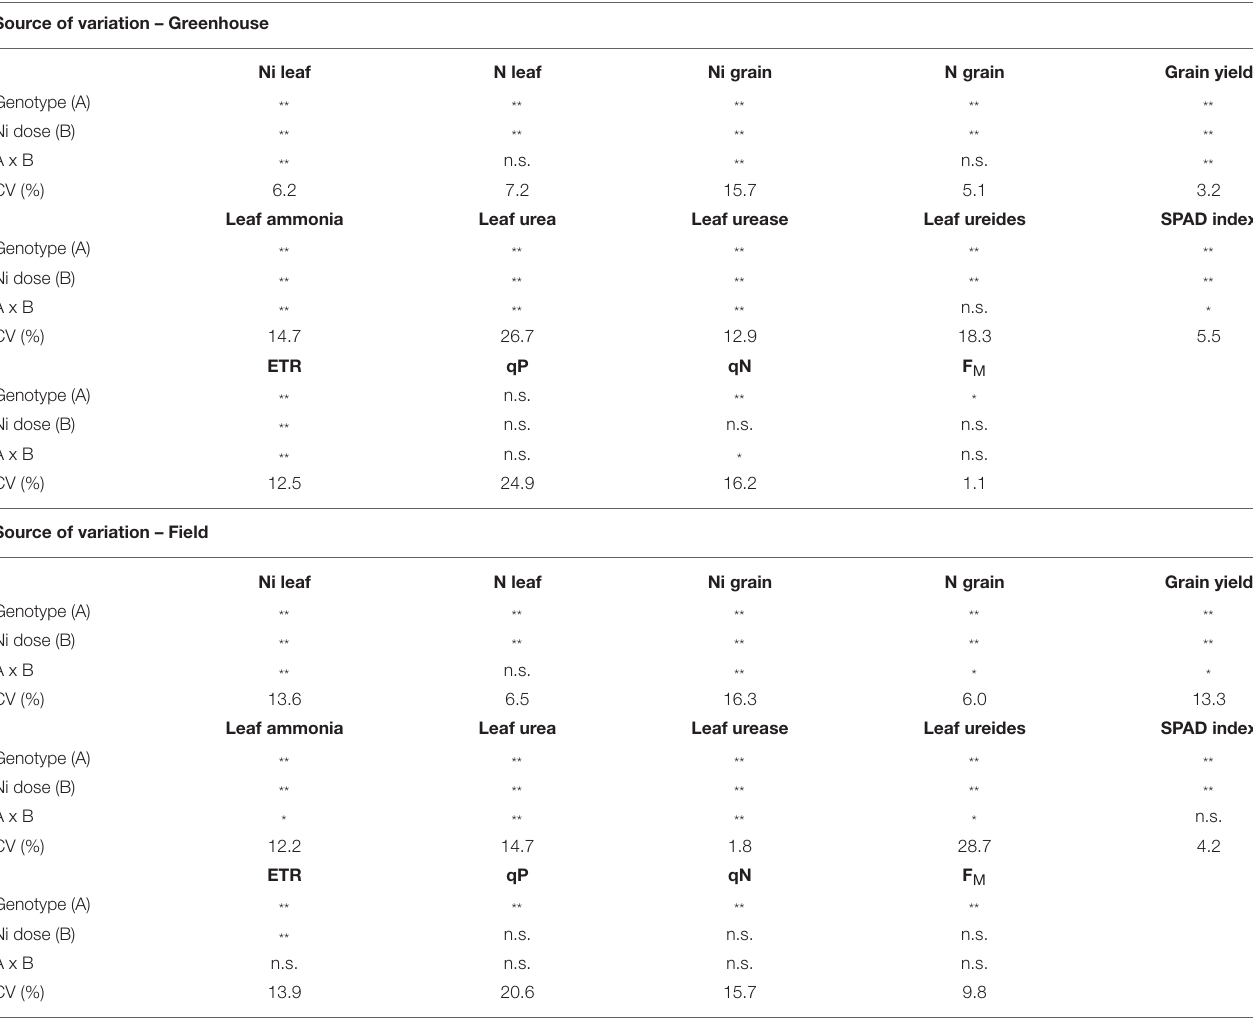
TABLE 3 | Two-way analysis of variance of 15 soybean genotypes and two near-isogenic lines (NILs) cultivated in greenhouse and field fertilized with 0.0mg of Ni kg − 1 and 0.5mg of Ni kg − 1 .